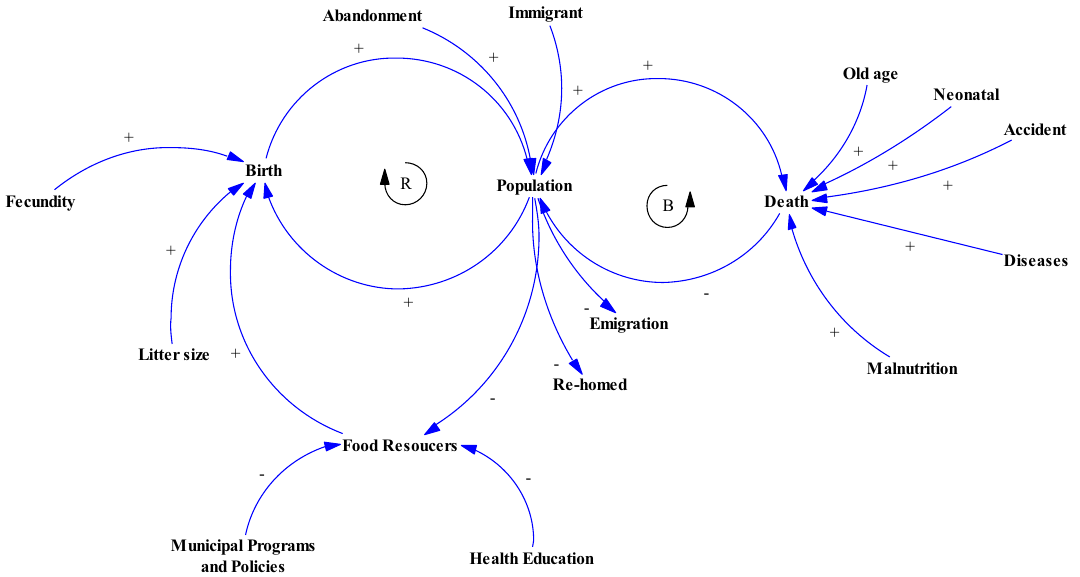
Figure 4. Causal Loop Diagram (CLD) showing parameters with major effects on free-roaming dog population. The arrows demonstrated cause-and-effect communication between a couple of variables, when two variables are linked in a CLD. When the two variables move in the same way this was represented by a “+”, and the reverse is indicated by a "−". Positive feedback loops showed by “R” while negative feedback loops showed by